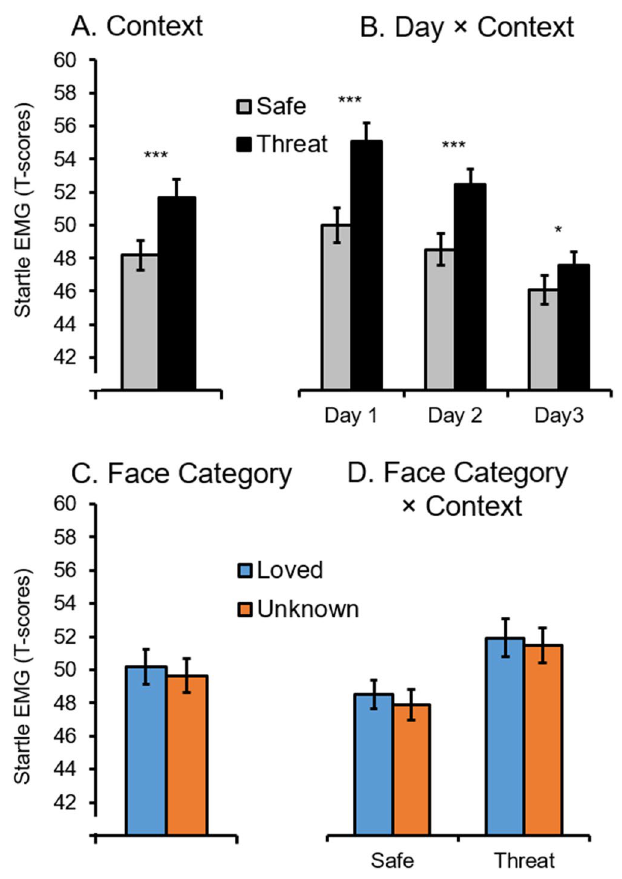
Figure 3. Mean startle reflex as a function of ( A ) instructed context condition, ( B ) context across test days, ( C ) face category, and ( D ) interaction of face category by context condition (M and SEM, *** p < 0.001, * p <